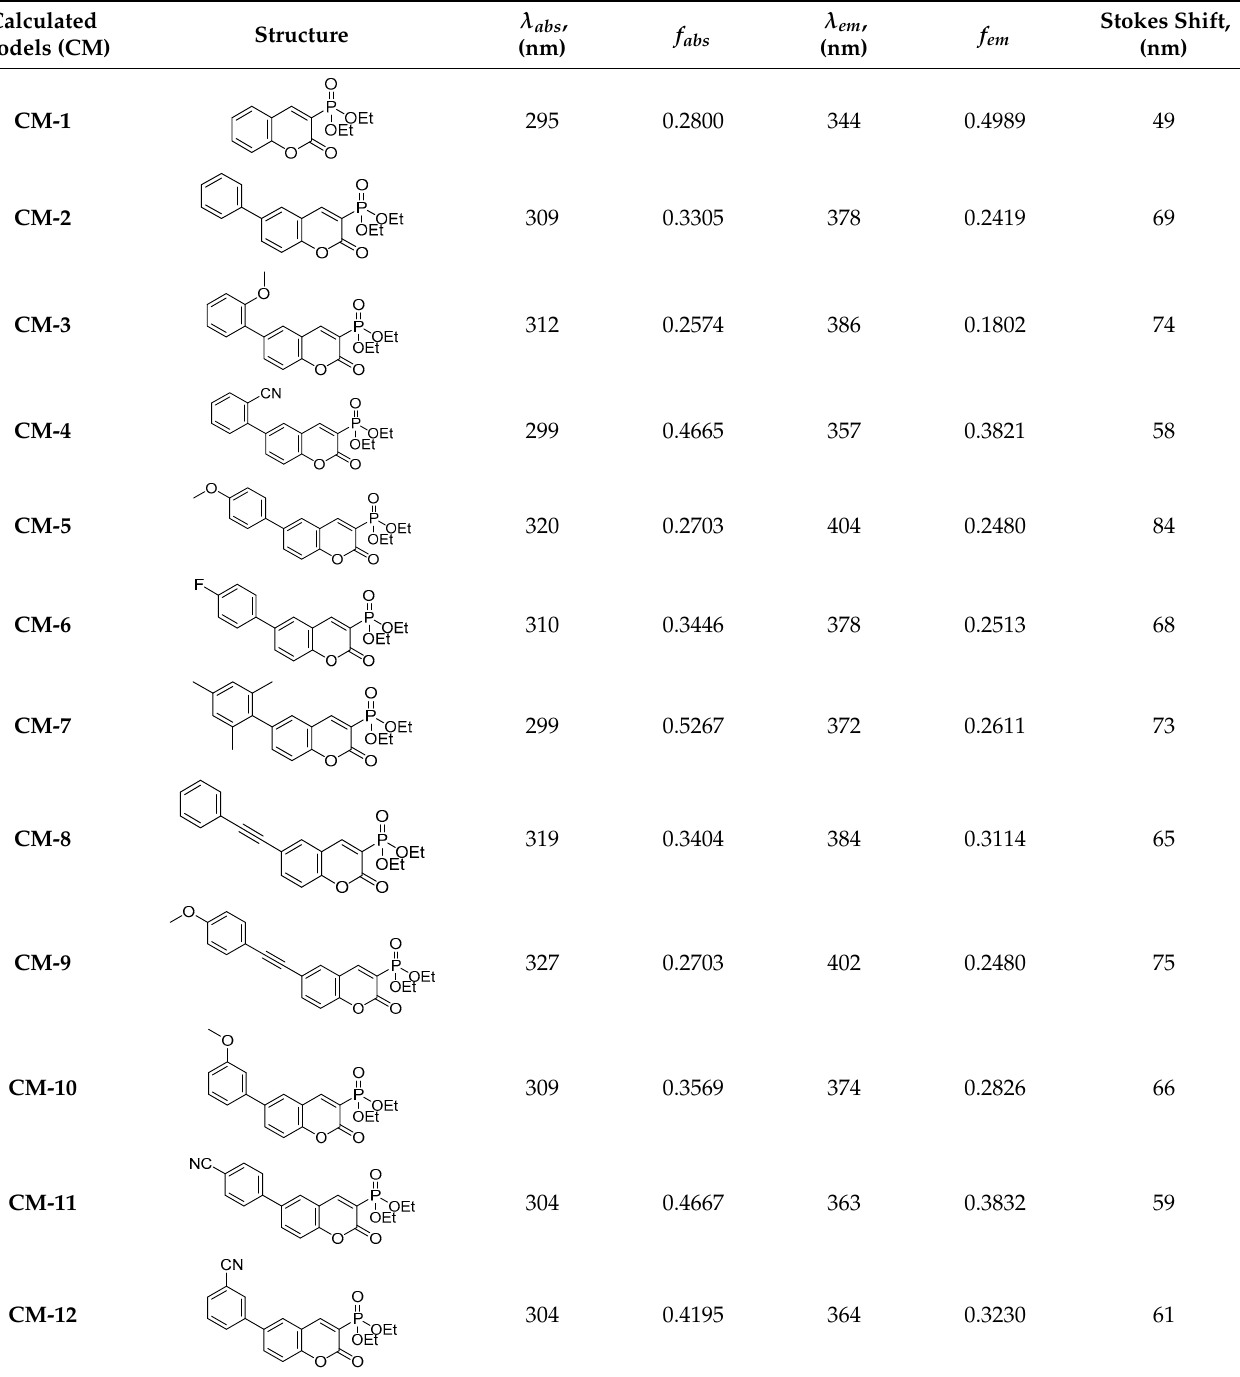
Table 1. Calculated excitation— λ abs and emission wavelengths— λ em , f —oscillator strengths, Stokes shifts.